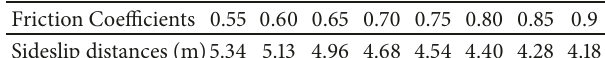
Table 1: Sideslip distances of A-type transport under different friction